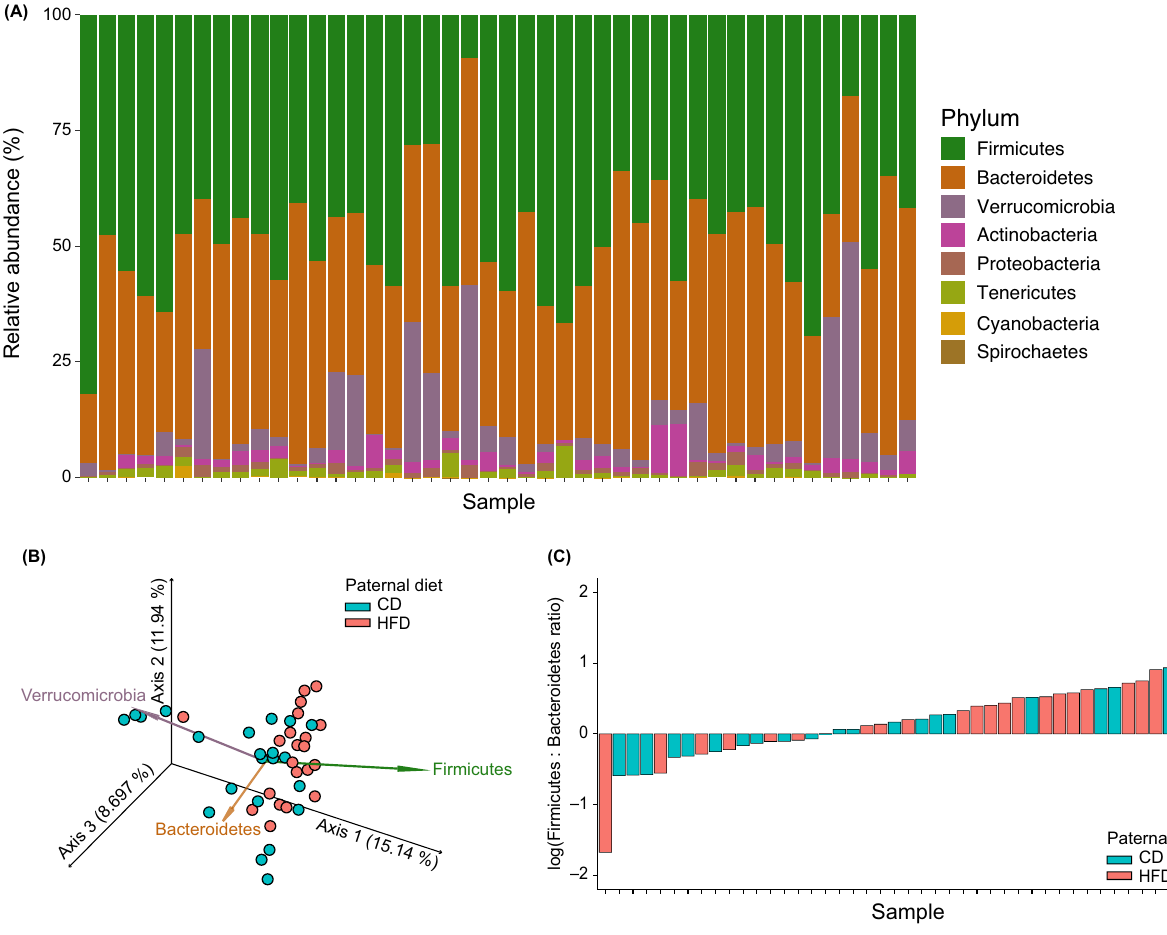
Figure 5. Ratios of relative abundances of the two most dominant phyla, Firmicutes and Bacteroidetes, differ between F 1 offspring of sires fed control diet (CD) and F 1 offspring of sires fed high-fat diet (HFD). ( A ) Stacked bar plot showing the relative abundances (%) of phyla observed in each sample, represented as individual columns. ( B ) Compositional biplot vectors show that Firmicutes and Bacteroidetes, in particular, drive differences in F 1 offspring fecal microbiomes. Biplot vectors are superimposed over the unweighted UniFrac distances shown in this Emperor plot after a rarefaction depth of 3136 sequences was applied to the data. ( C ) Samples ordered by increasing log values of the Firmicutes: Bacteroidetes ratio and colored according to paternal diet condition (CD or HFD) demonstrate that F 1 offspring of HFD sires have greater Firmicutes to Bacteroidetes (log10F:B ratio) > 0 than F 1 offspring of CD sires. CD control diet, HFD high-fat Fig. 6G–I). Unbiased classification of samples based on microbial composition extended our understanding of how the fecal microbiota of F 1 rat offspring in this study were influenced by F 0 conditions beyond core diversity analyses and relied on predictive accuracy scores and machine learning model performance indicators in the receiver operating characteristic (ROC) scores (Fig. 6A,D,G). Briefly, macro- and micro-average values for the prediction of samples to F 1 offspring of CD or HFD sires based on features of the fecal microbiome were greater than chance alone (AUC = 0.95 and 0.95, respectively; Fig. 6A) and 95% accurate (Fig. 6B). The feature importance plot in Fig. 6C shows that the presence or absence of Ruminococcus and Lactobacillus spp. together drove the classification of samples into paternal CD or HFD progeny. Additional features included Blautia sp., Ruminococcus flavefaciens, Bifidobacterium pseudolongum , and unknown members of the Bacteroidetes class S24-7, family Rikenellaceae , order Clostridiales, and order Mollicutes RF39 (Fig. 6C). Macro- and micro-average values for the prediction of samples to F 1 offspring reared with dams in SH or SNH environments based on features of the fecal microbiome were also greater than chance alone (AUC = 0.85 and 0.85, respectively; Fig. 6D) and 84% accurate (Fig. 6E). The feature importance plot in Fig. 6F demonstrates that there exists some overlap in features used in the classification of samples by paternal diet and maternal housing condition, including Blautia sp. and an unknown member of the Bacteroidetes class S24-7 (Fig. 6C,F). Unique features that drove the classification of SH and SNH conditions included unknown members of the family Ruminococcaceae and Clostridiaceae , Allobaculum sp., Turicibacter sp., Prevotella sp., Akkermansia muciniphila , and multiple features in the genus Lactobacillus (Fig. 6F).